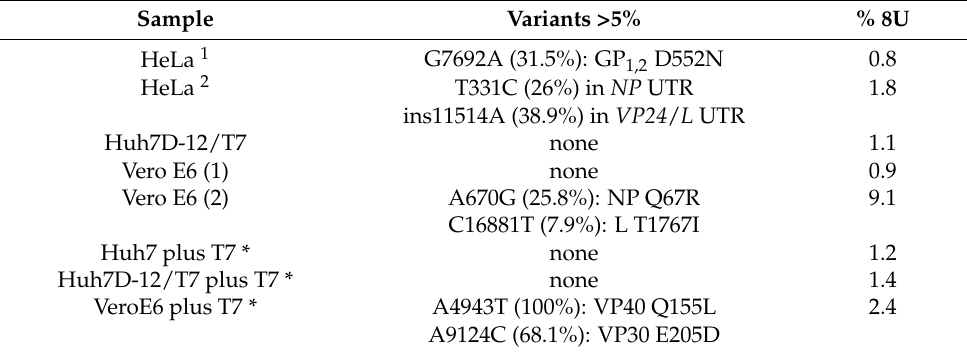
Table 2. Minor variants detected in rEBOV/Mak-G3864.1 mutant “r412”